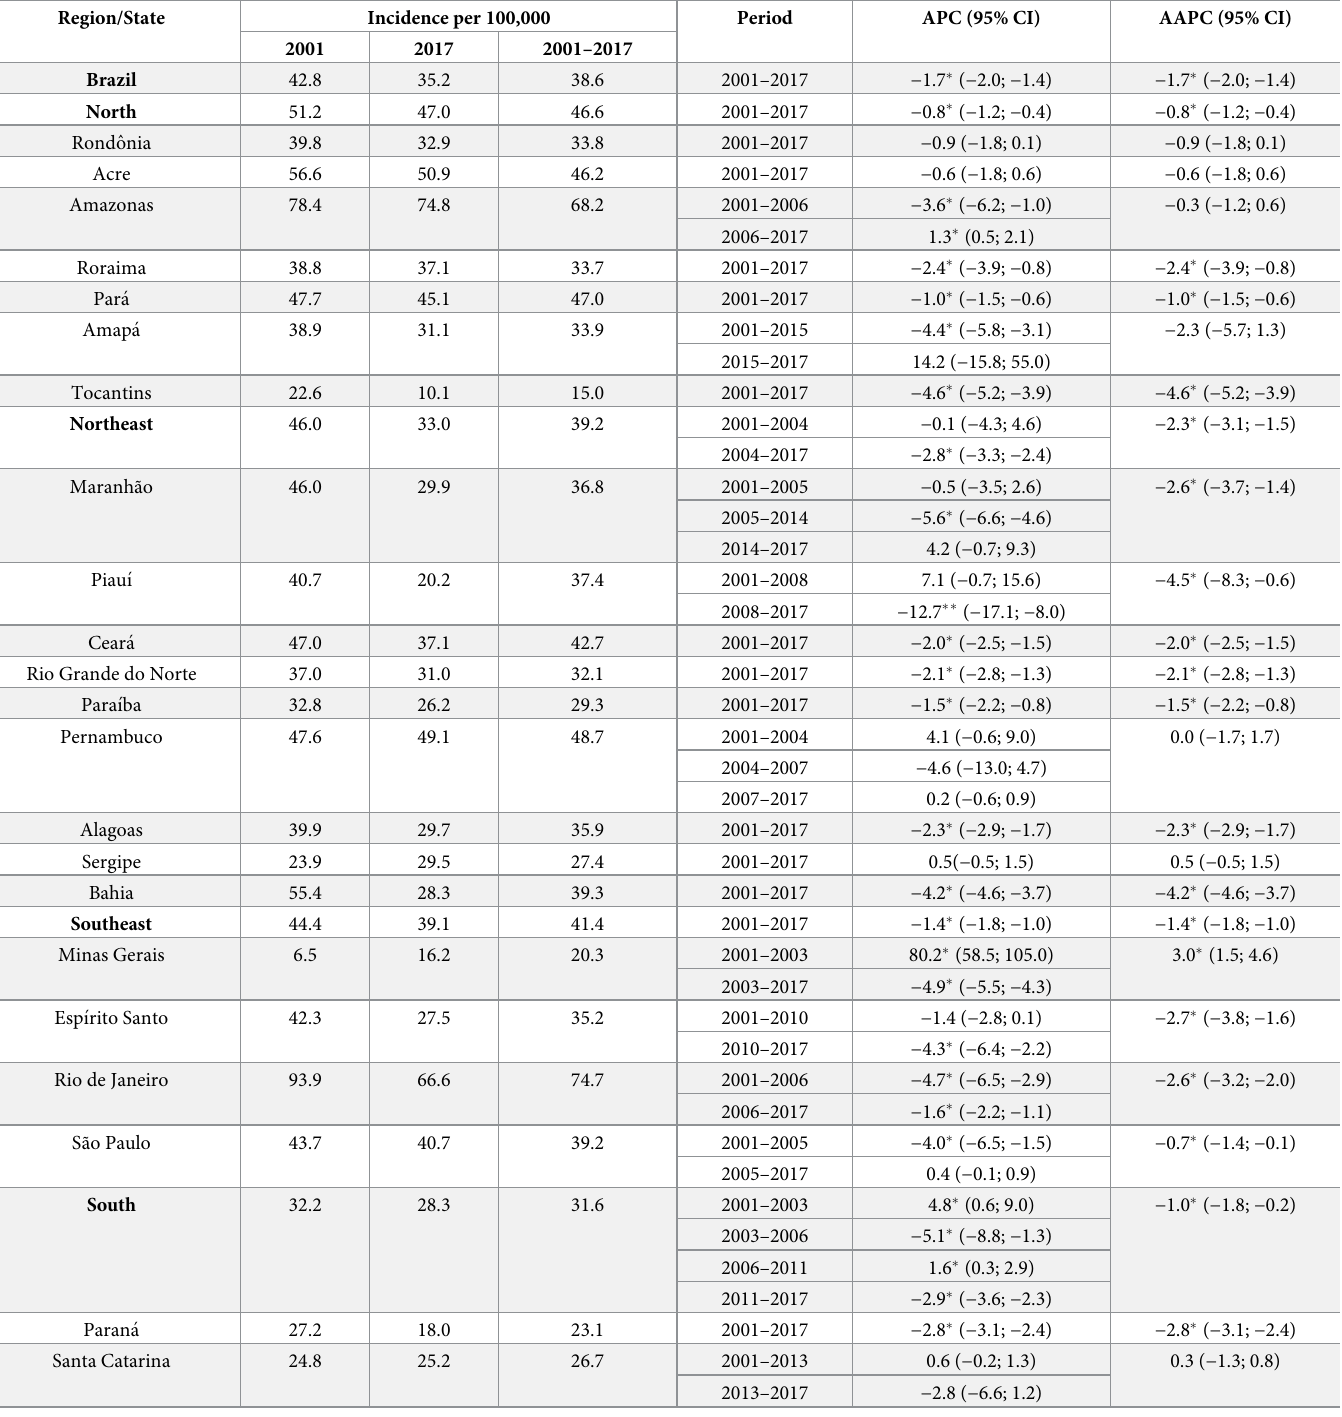
Table 1. Trend of the incidence rate (100,000 inhabitants) of tuberculosis by Brazilian regions and states. 2001–2017.